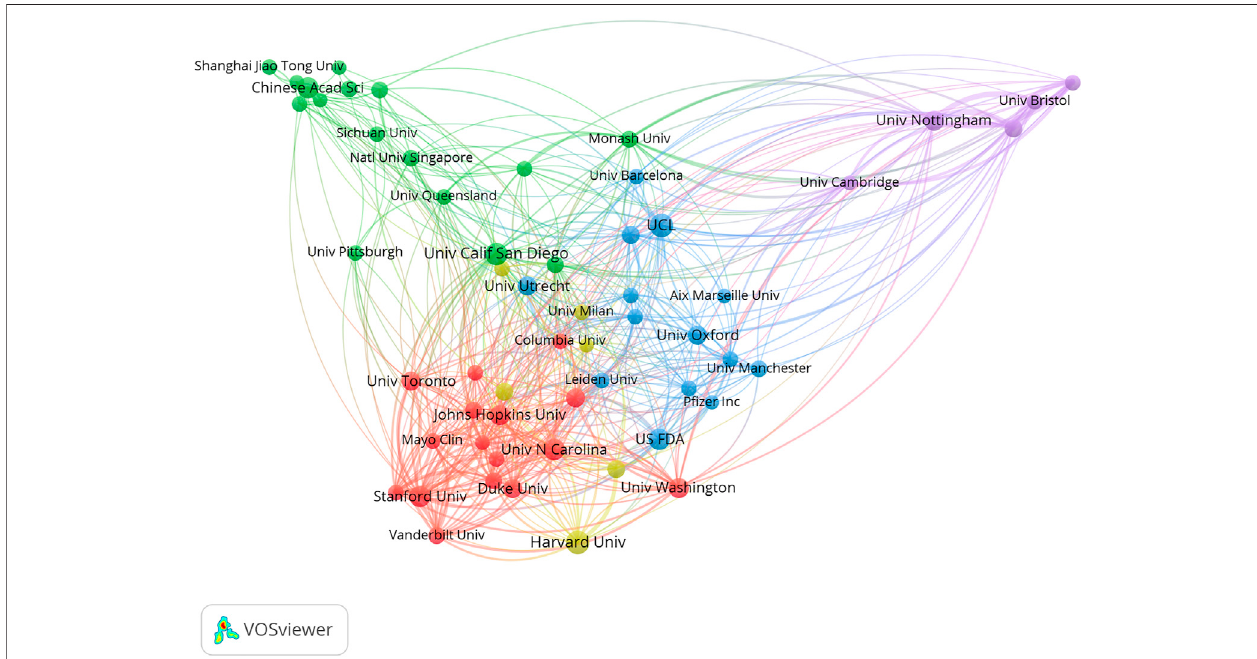
FIGURE 7 | Map of collaborative networks among institutions of high-impact papers in pharmacology and pharmacy research around the world.